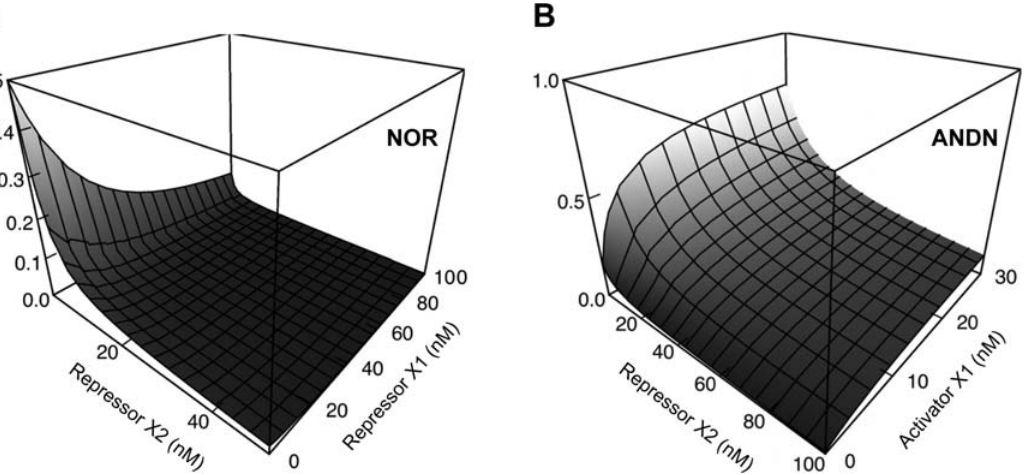
Figure 4. Simple thermodynamic models of NOR and ANDN logic phenotypes. (A) Two repressors generate a NOR logic. (B) One repressor and one activator generate an ANDN logic. The model assumes non-interactive regulators that compete with (repressors) or help (activators) RNA polymerase bind to the promoters (see Materials and Methods for details). As the concentration of the active repressors or activators (x and y axis) is varied, the transcription of the gene they control changes (z axis).